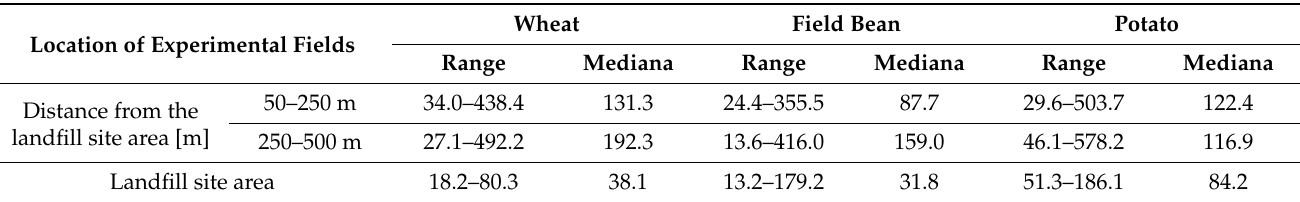
Figure 1. The total numbers of bacteria in vegetative stage (cfu g − 1 dry soil) for the soil near the municipal landfill site (columns—mean values, whiskers—mean concentration ± standard deviation). For description of sampling sites see Table 1. Table 2. The number of bacteria in the vegetative stage in the soil under the cultivation of crops in the area around the municipal landfill site [ × 10 4 cfu · g − 1 dry